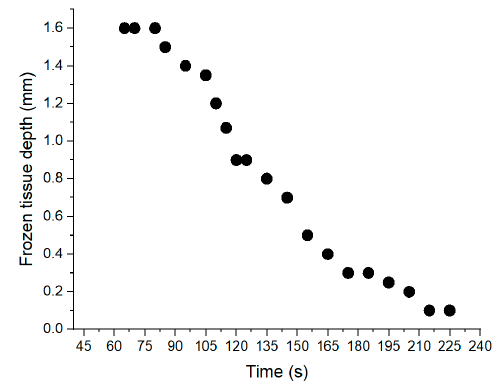
Figure 11. Measurement of frozen depth (mm) with ultrasound as a function of thawing time (s) measured from side-A.